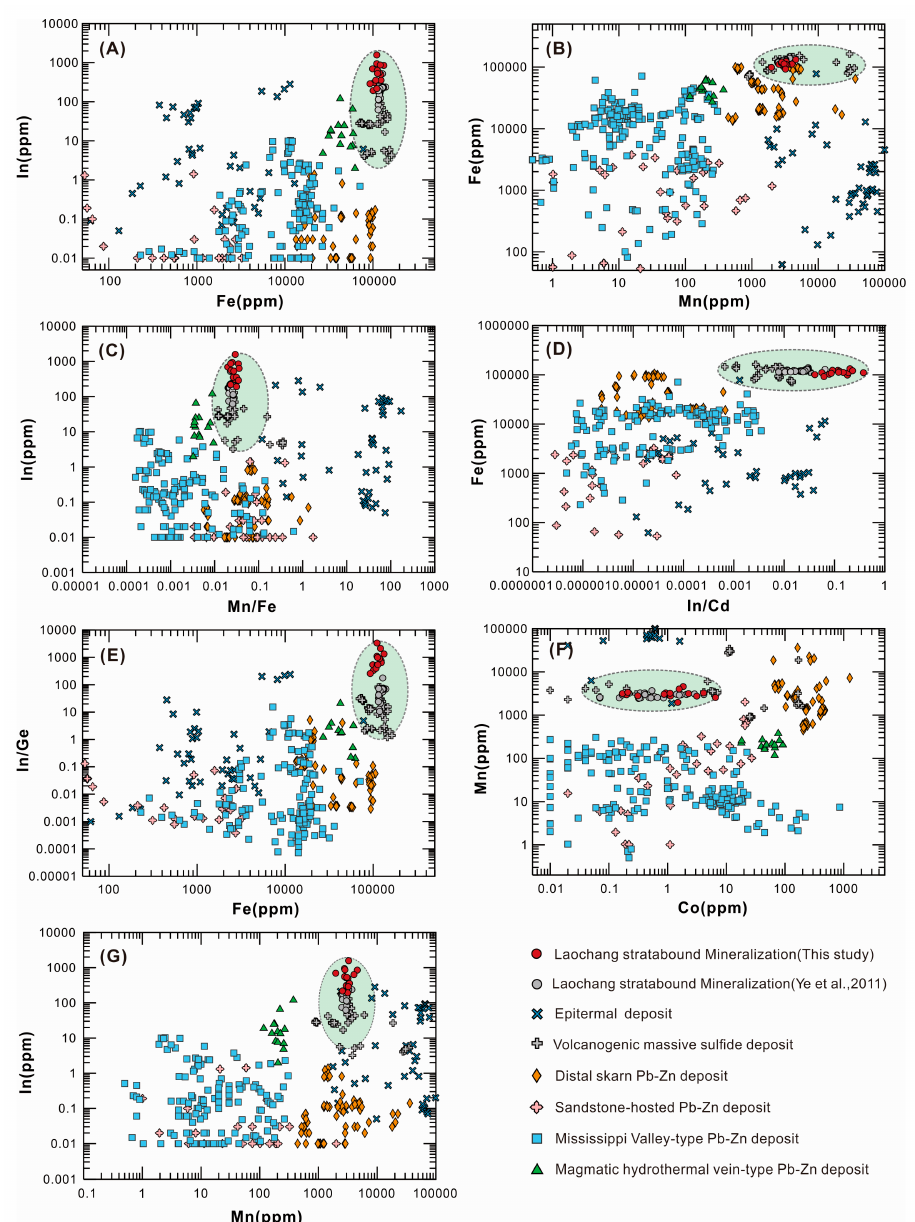
Figure 13. Binary plots of Fe vs. In ( A ), Mn vs. Fe ( B ), Fe vs. In/Ge ( C ), Mn vs. Co ( D ), Fe vs. In/Ge ( E ), Mn vs. Co ( F ) and Mn vs. In ( G ) in sphalerite from the Laochang stratabound ores and Mississippi Valley-type (MVT), volcanogenic massive sulfide (VMS), epithermal, distal skarn, Sandstone-hosted, magmatic hydrothermal vein-type Pb-Zn deposits in China, NE Europe, Canada, Mexico and Japan. Note: Plots are based on data from Cook et al. [69], Ye et al. [71,75], Zhou et al. [74] and Wei